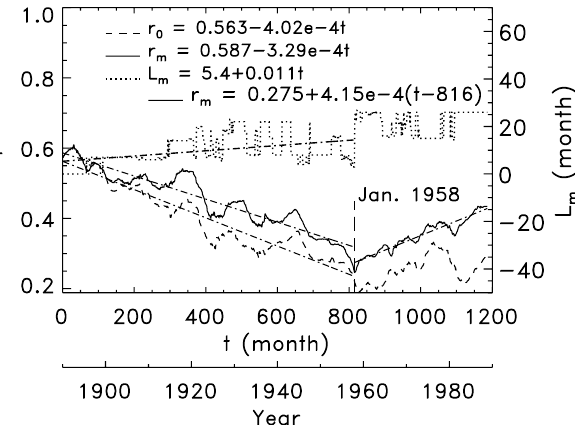
Fig. 2. Trends of r 0 (dashed), r m (solid) and L m (dotted) for a 528-month running time